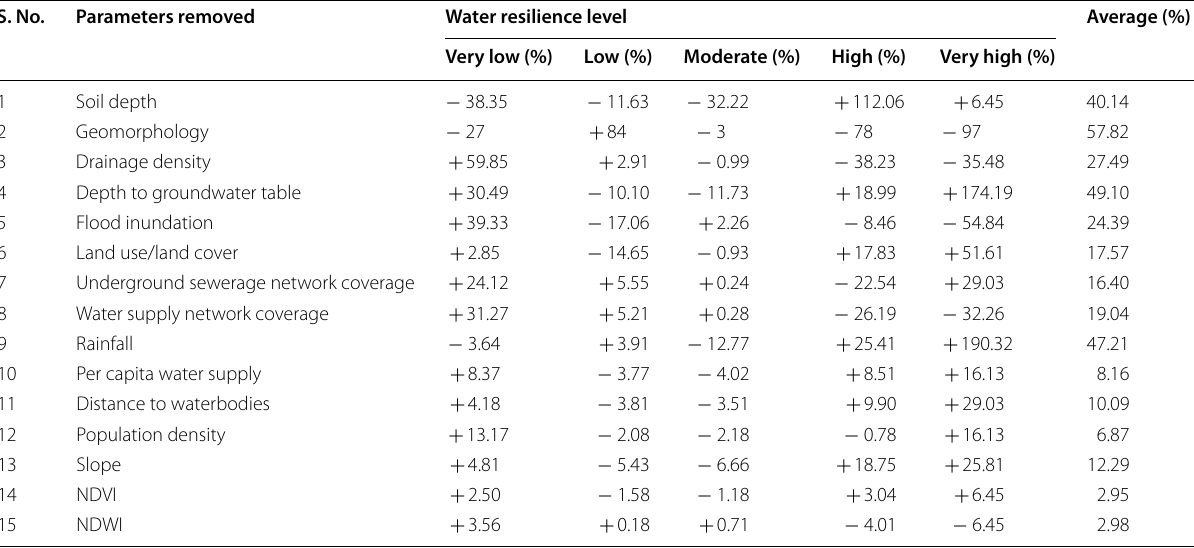
Here denotes increase in the area; +